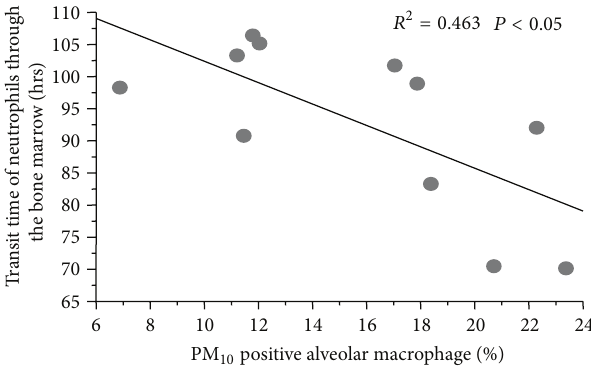
Figure 4: Relationship between the fraction of AMs that phago- cytosed PM 10 particles and the transit time of PMN though the bone marrow. Rabbits were exposed to 5mg PM 10 (EHC-93) twice a week for 4 weeks, and AMs with particles in their cytoplasm were enumerated using quantitative histological methods. Dividing PMNs in the marrow were labeled with 5-bromo-2-deoxyuridine and the transit time of PMN through the bone marrow was measured. Faster transit times of PMN through the marrow were associated with more AMs with phagocytosed particles ( 𝑅 2 = 0.46, 𝑃 < 0.05 )